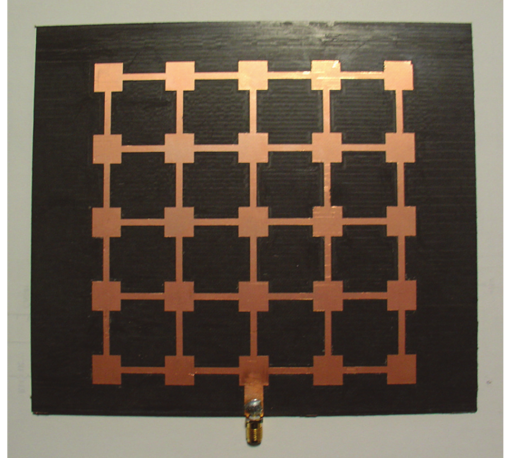
Figure 5: The fabricated array antenna.